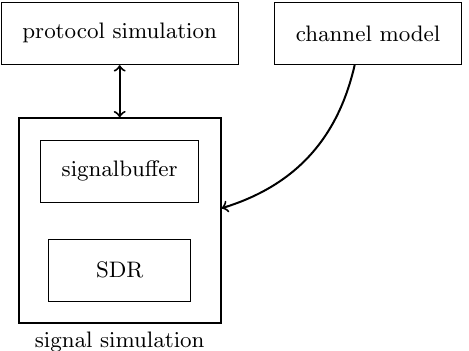
Figure 5: Structure of a network simulator con- nected to the signal